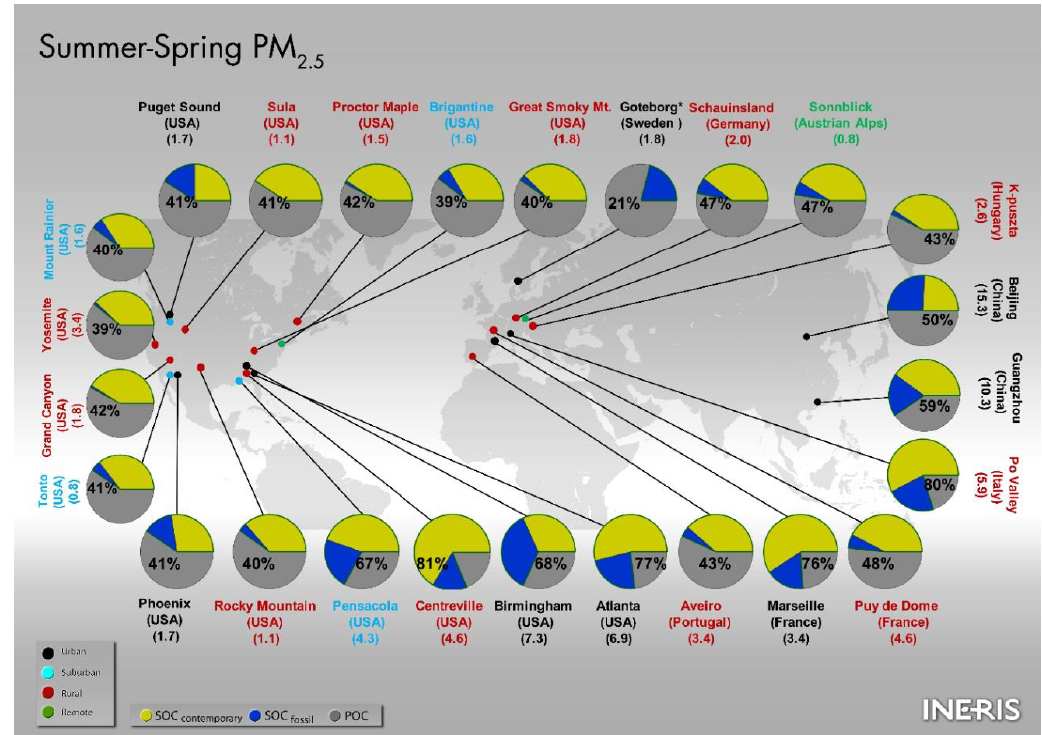
Figure 8. Spring–summer SOC contributions to PM 2.5 OC over the world for all the selected sites from 2006 to 2016 using 14 C (Radiocarbon) measurements. OC concentrations (µgC m −3 ) for each site are indicated into brackets. % refers to the sum of SOC fossil fuel + SOC contemporary . In black, urban sites; in blue, suburban sites; in red, rural sites and in green, remote sites. * Contemporary SOC was not reported.